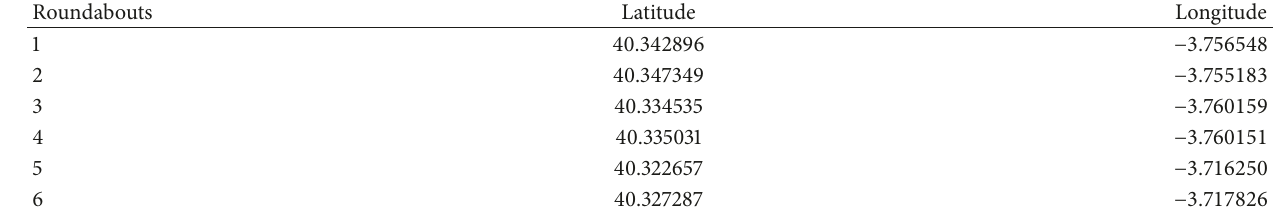
Table 3: Roundabouts locations.